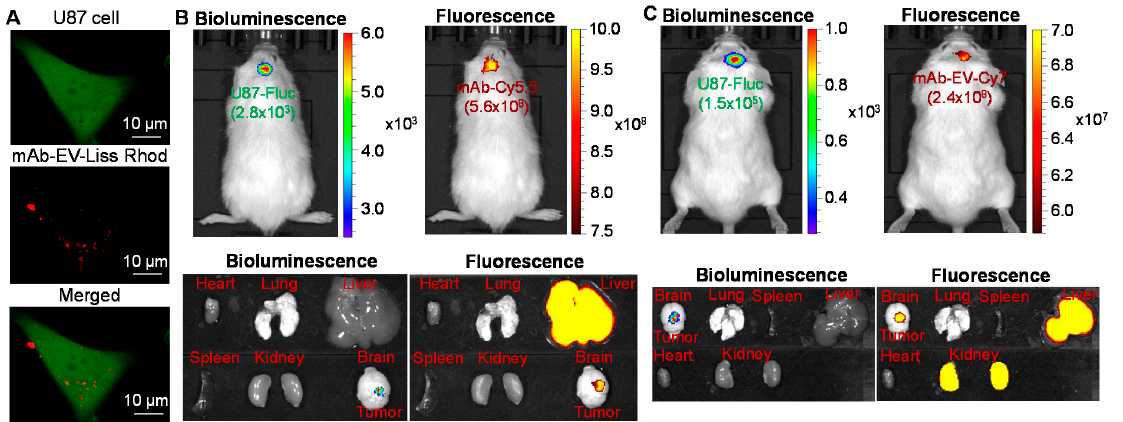
Figure 3. Evaluation of GBM targeting of mAb-EV. ( A ) Live-cell CLSM imaging of mAb-EV-Liss Rhod internalization in U87 cells. Two-color CLSM: whole cell labeled with GFP (displayed as green) and mAb-EV labeled with Liss Rhod (displayed as red). Scale bar equals 10 µm. ( B ) In vivo live animal and ex vivo IVIS imaging of tumor and important organs to analyze tumor targeting and biodistribution of mAb-Cy5.5 at 24 h post i.v. injection in U-87-FLuc intracranial xenograft mouse model ( n = 3). ( C ) IVIS imaging of the live animal and tumor and organs to analyze tumor targeting and biodistribution of mAb-EV-Cy7 at 24 h post i.v. injection ( n = 3).